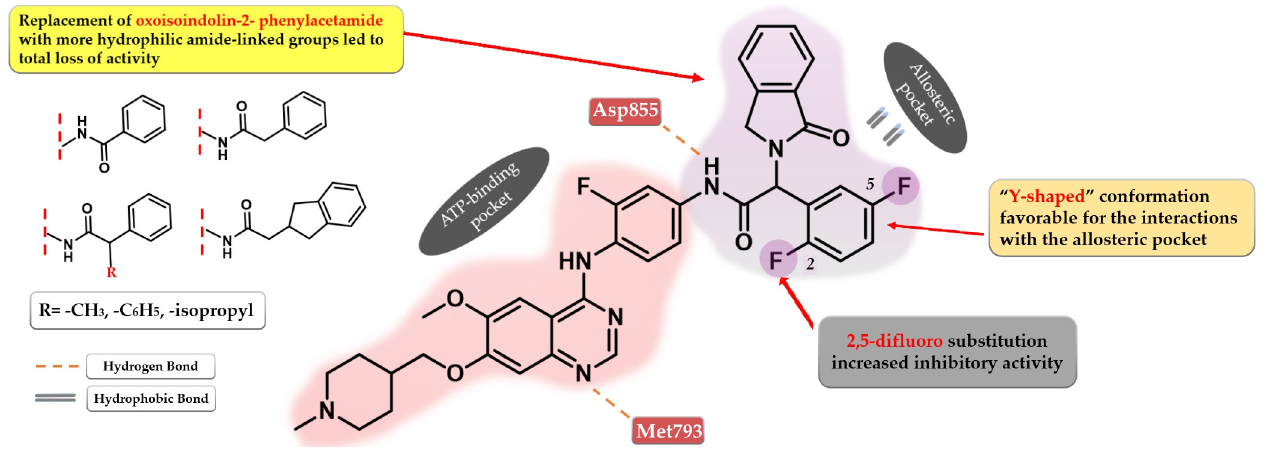
Figure 30. Structure–activity relationship and molecular docking of compound 42 in the human EGFR del19/T790M/C797S kinase domain (PDB code 5D41), as reported by Li et al. [206].